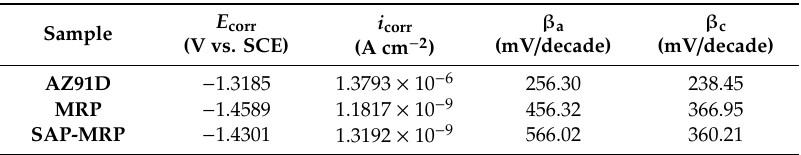
Figure 2. Polarization plots for AZ91D alloy as well as the MRP and SAP-MRP coated alloys in the simulated acid rain solution. Table 3. The related parameters of the polarization plots for AZ91D alloy as well as the MRP and SAP-MRP coated samples in the simulated acid rain.